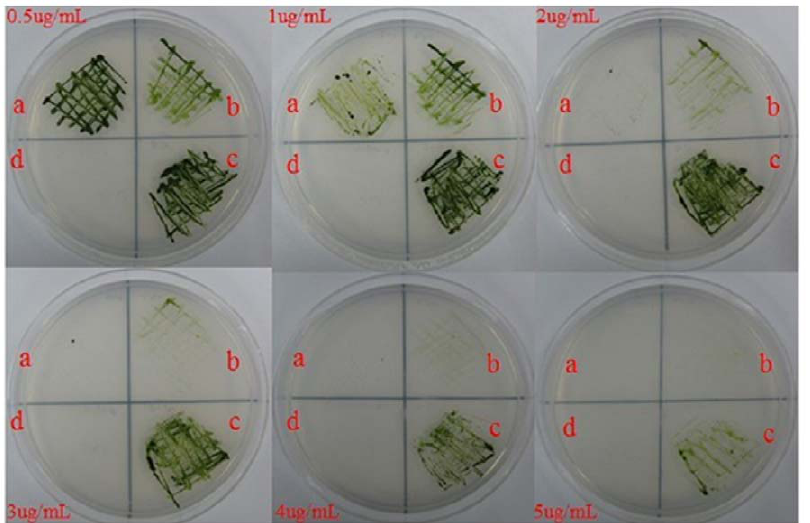
Figure 6. Sensitivity analysis of transgenic strains MT-Bs to Zeomycin. a: wild-type strain CC-124; b: respiratory deficient strain CC-2654; c: transgenic strain MT-B; d: empty control.